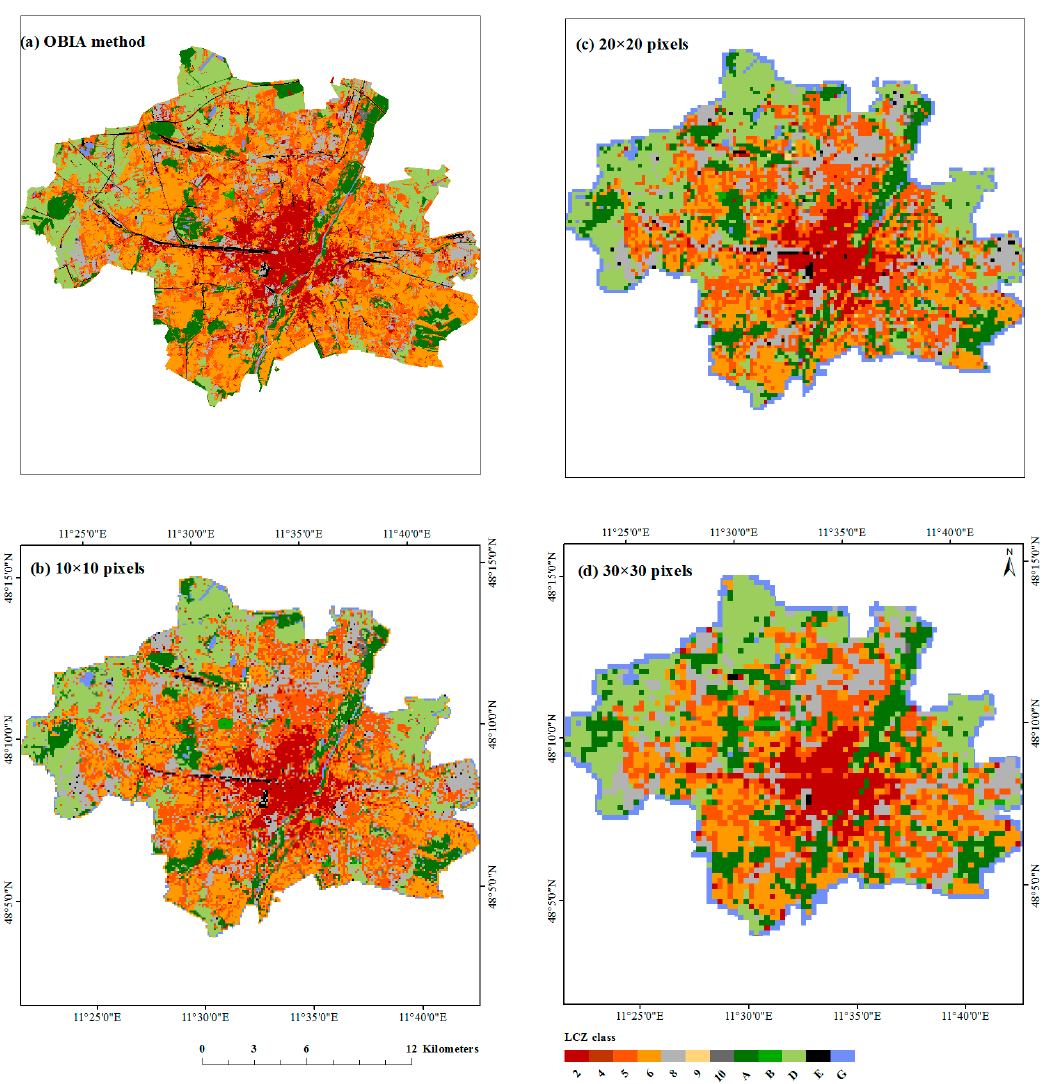
Figure 3. Mapping results for Munich using the OBIA method and the pixel-based method. ( a ): the result based on OBIA; ( b ): the result based on 10 × 10 pixels; ( c ) the result based on 20 × 20 pixels; ( d ) the result based on 30 × 30 pixels.